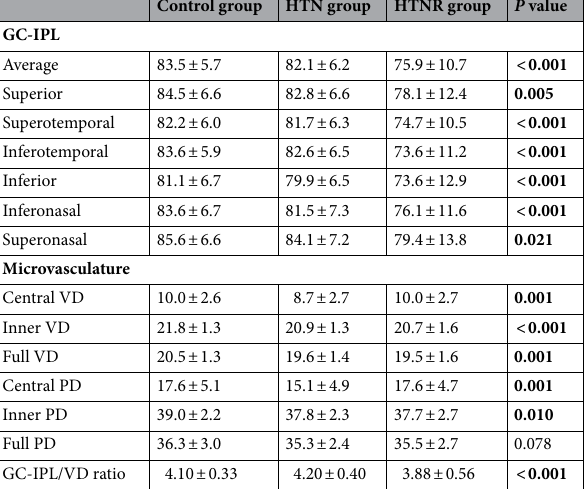
Table 2. Ganglion cell-inner plexform layer thickness and macular microvasculature parameters in each group. GC-IPL ganglion cell-inner plexiform layer, VD vessel density, PD perfusion density. P value after adjustment for covariants. All values are expressed as the mean ± standard deviation (μm). Values in boldface ( P < 0.050) are statistically significant.